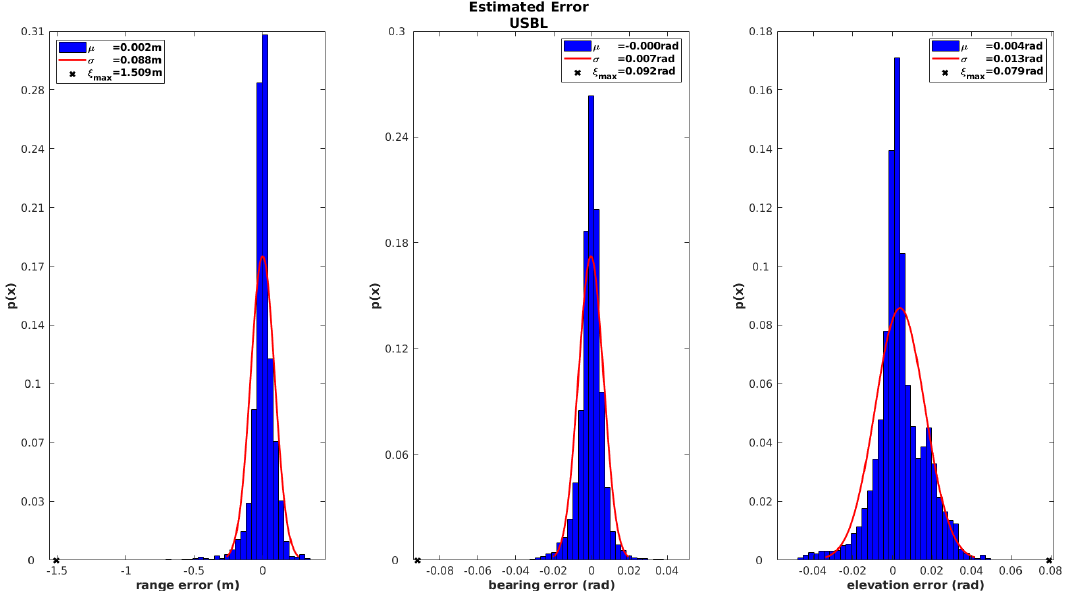
Figure 14. Histograms of the innovation sequence for the iUSBL observation model, defined in terms of range and directional